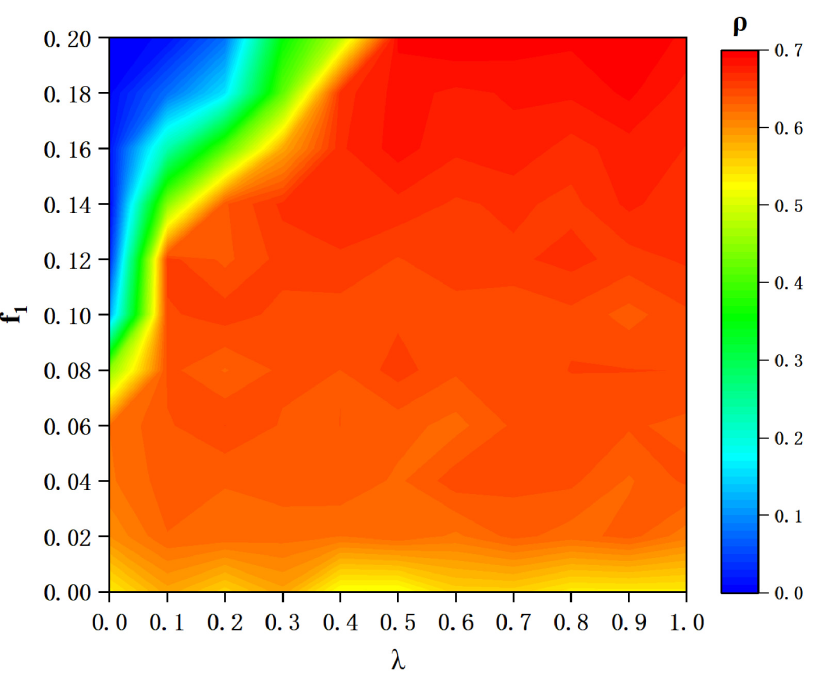
joint action of different value of f 1 and λ . The X-axis is λ (from 0 to 1) and the Y-axis is f 1 (from 0 to 0.2).